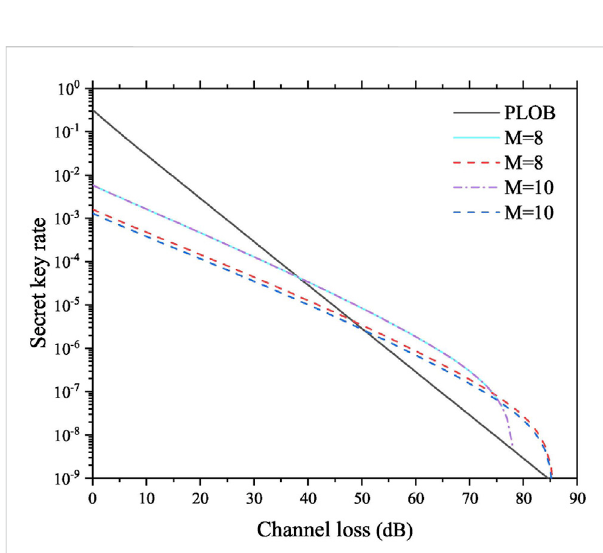
FIGURE 2 Comparison results of Protocol I and [33] with M = 8 and 10. The solid curves represent the results of Protocol I, and the dashed curves represent the results of [33].